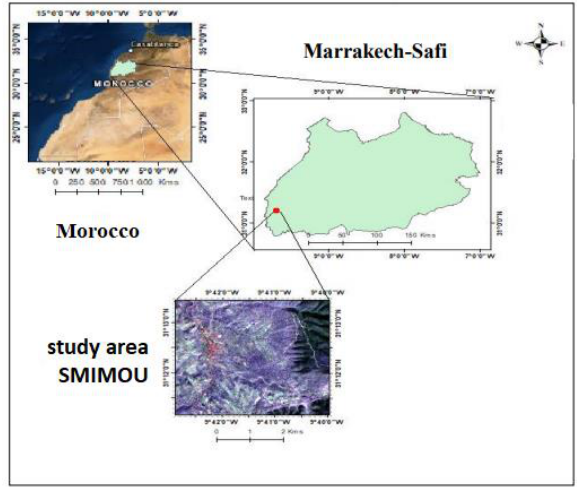
Figure 1 . Location of the SMIMOU study